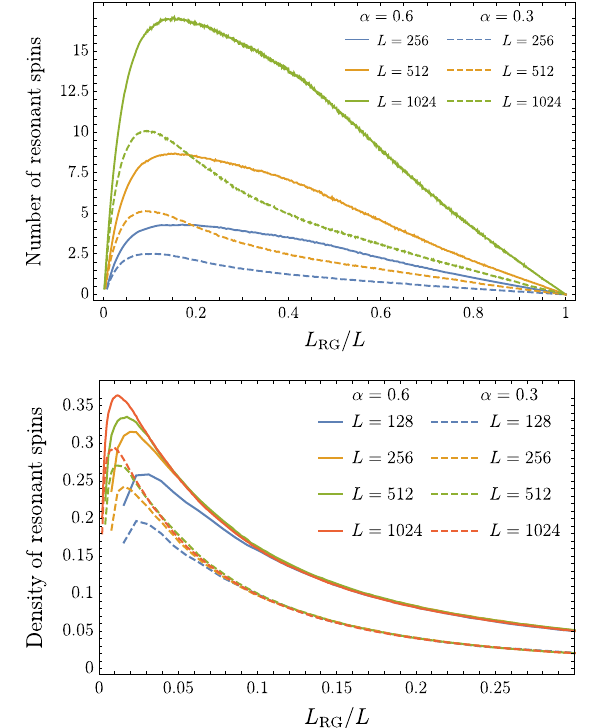
FIG. 16. Evolution of the number (top) and the density (bottom) of the resonant blocks spins in the course of the SDRG. The horizontal axes shows the ratio of the current system size to the initial length of the